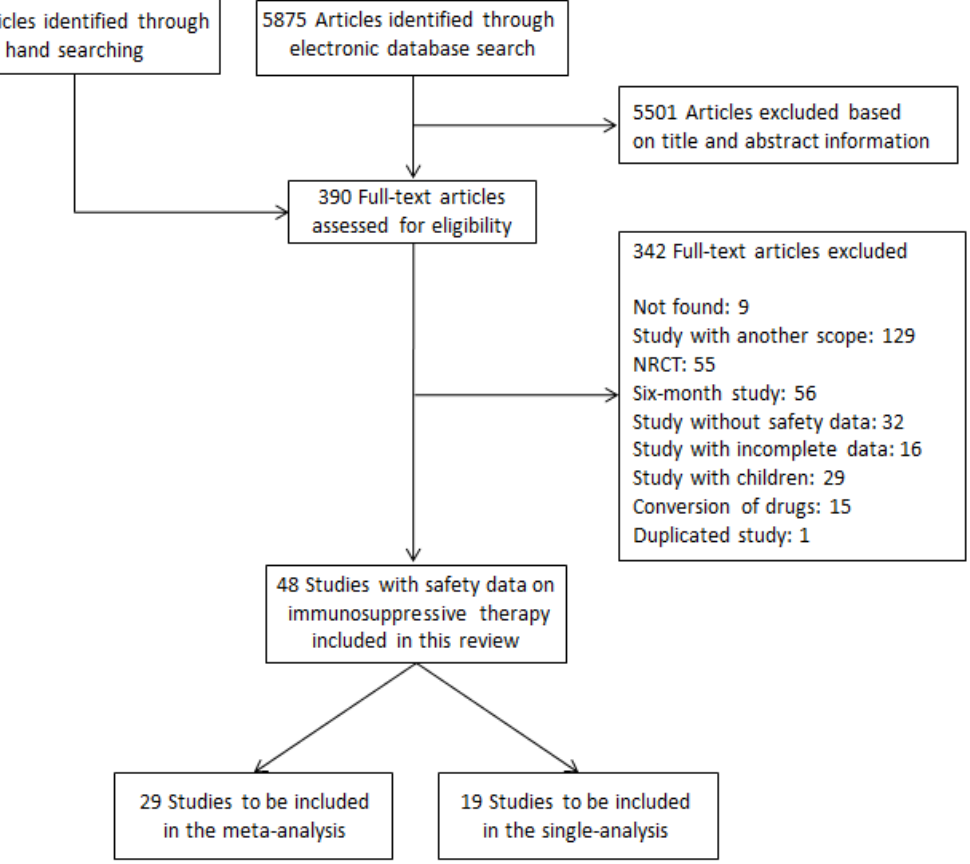
Figure 1. Flow chart of studies included in the systematic review.